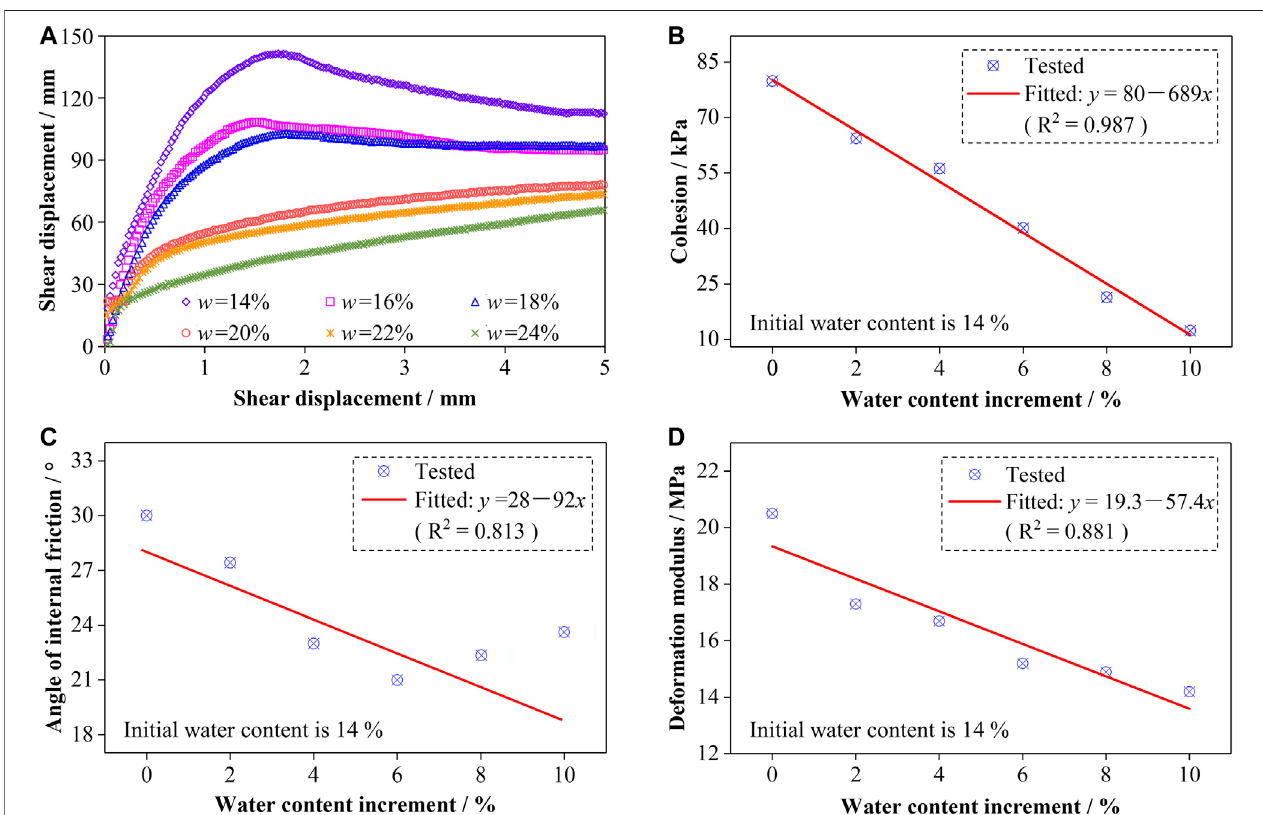
FIGURE 6 | Variations of shear stress-shear stress curves (A) , cohesion (B) , angle of internal friction (C) and deformation modulus (D) of the loess with the water content.